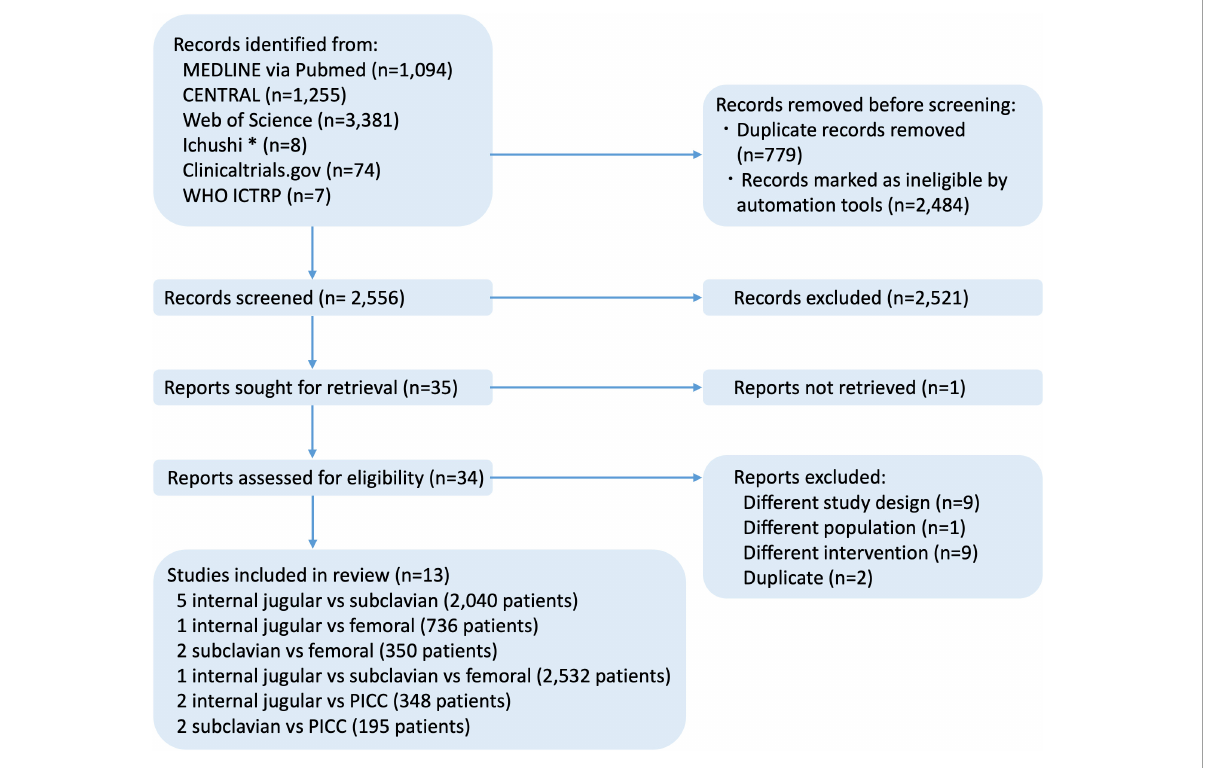
FIGURE1 Flow diagram of studies included in this review. *Ichushi is a database of Japanese research papers. CENTRAL, cochrane central register of controlled trials; ICTRP, international clinical trials registry platform; MEDLINE, medical literature analysis and retrieval system on line; WHO, world health